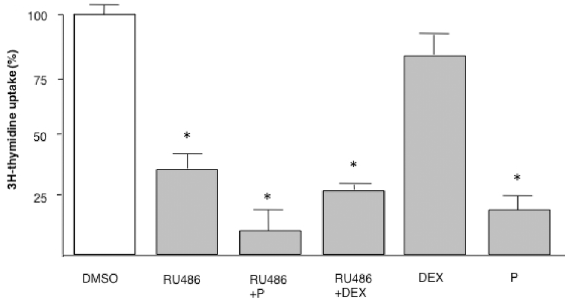
Figure 2. Dexamethasone (DEX) and progesterone (P) did not affect the inhibitory effect of RU486 on [3H]-thymidine incorpora- tion in SK-N-SH human neuroblastoma cells. SK-N-SH cells were treated with RU486 (10 m M), DEX (10 m M), or P (10 m M) alone or in combination for 24 h. Data are reported as the mean ± SD of three experiments done in triplicate. *P o 0.05 vs DMSO (ANOVA).